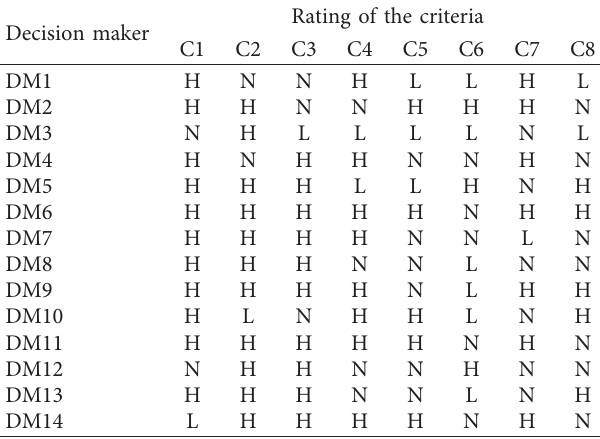
Table 4: Rating of the criteria using linguistic